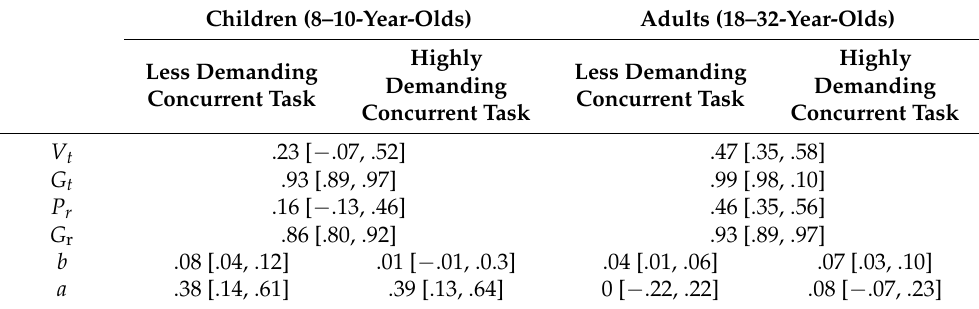
Table 1. Estimates (and 95% confidence intervals) of simplified CR model